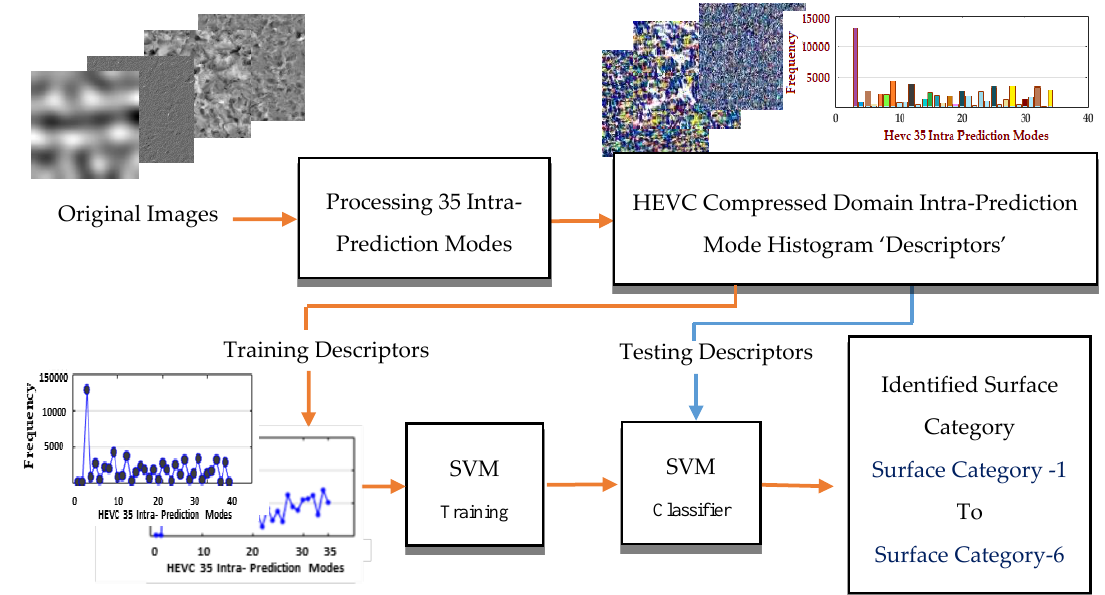
Figure 14 . Block diagram of the proposed model integrates the HEVC lossless intra prediction model with nonlinear support vector machine model.